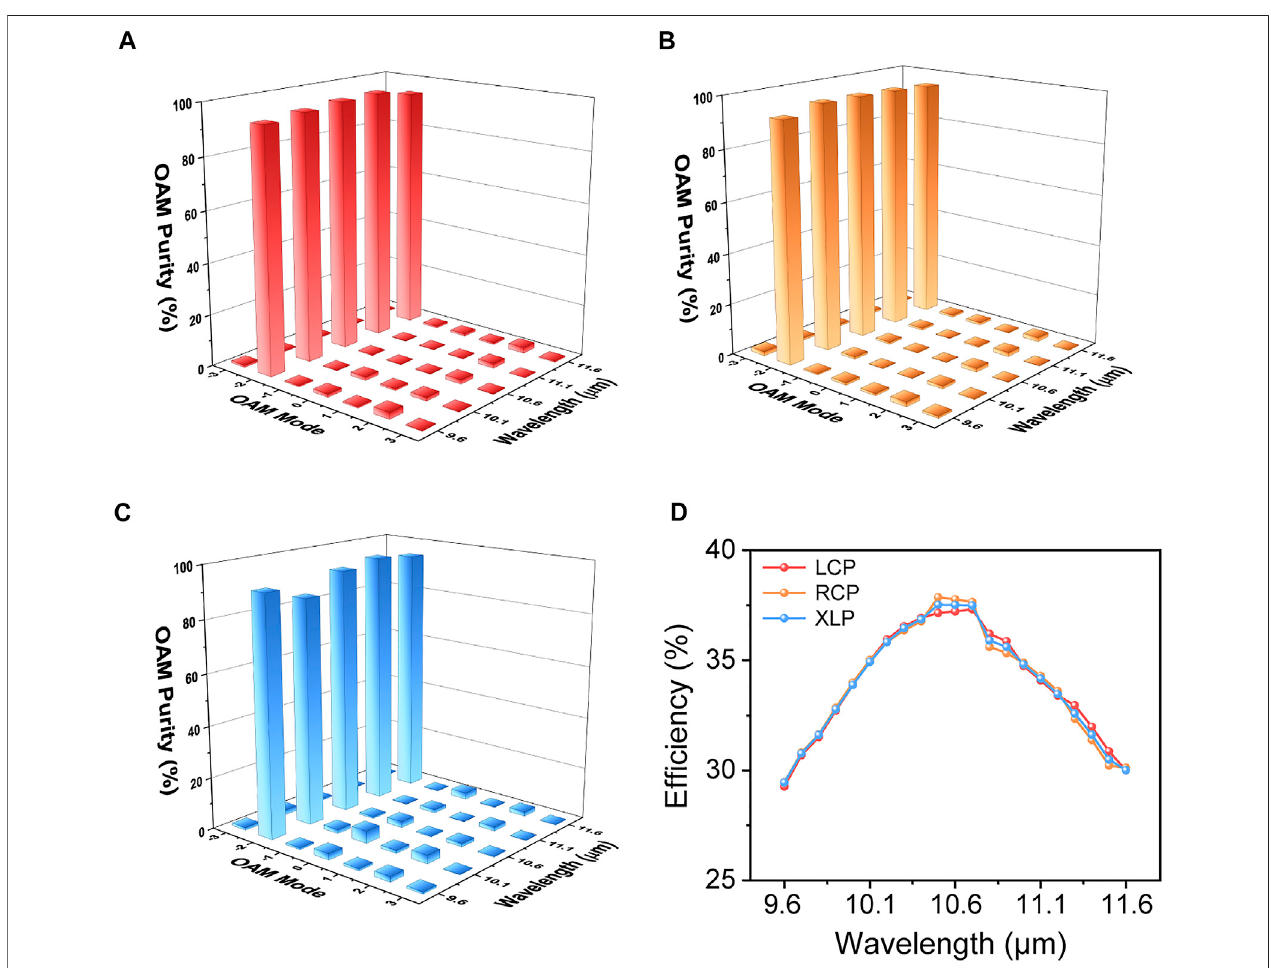
FIGURE 8 | Ef fi ciency and mode purity of the FOV generator. (A,B,C) Mode purity of the generated OV under LCP incidence, RCP incidence, and XLP incidence, respectively. (D) Ef fi ciency of the fl at FOV generator under LCP, RCP, and XLP incidence.